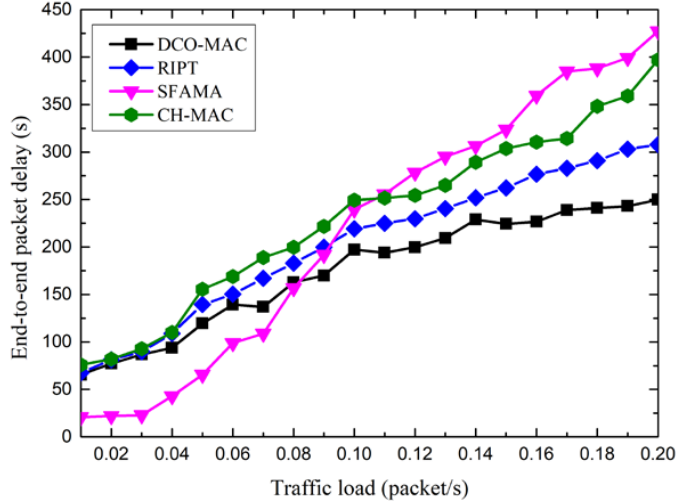
Figure 15. The end-to-end packet delay of the DCO-MAC protocol.